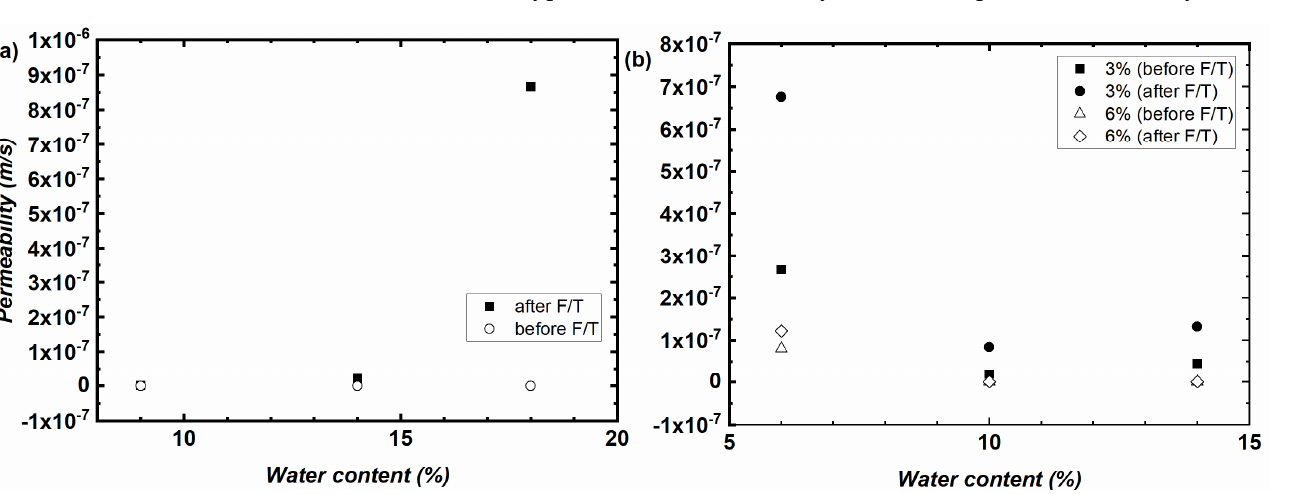
Figure 5. UCS ratio versus F/T cycles (adapted from [8,52,58]).